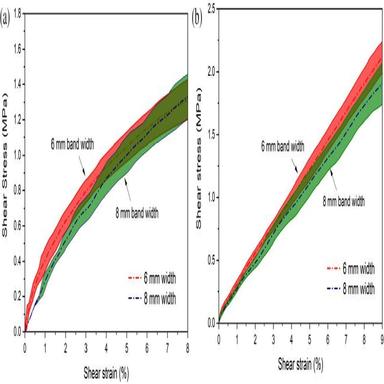
Shear stress vs shear strain with different tape widths for (a) IM7/8852 and (b) IMA/M21. The test rate was 0.01/s and the samples were made of 3 layers each. (For interpretation of the references to colour in this figure legend, the reader is referred to the web version of this article.)